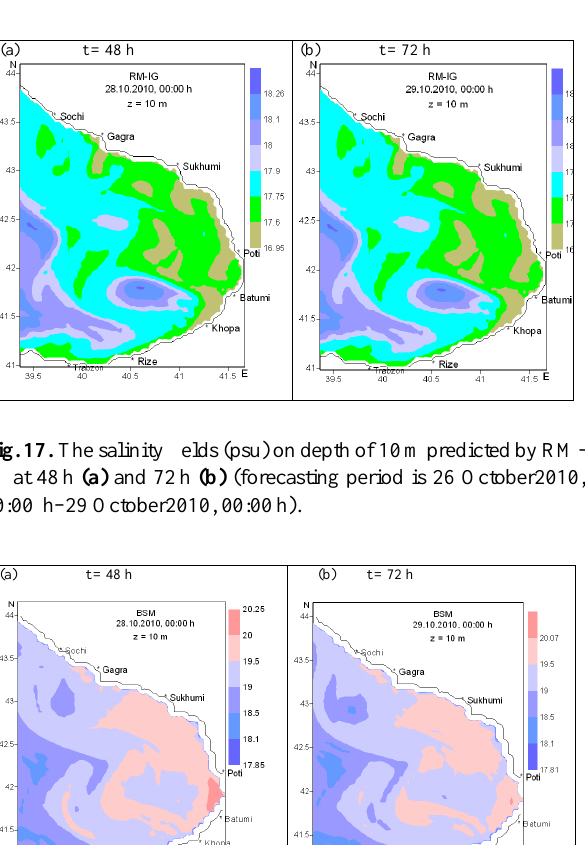
Fig. 17. The salinity fields (psu) on depth of 10 m predicted by RM-IG at 48 h (a) and 72 h (b) (forecasting period is 26.10.2010, 00:00 h – 29.10.2010, 00:00 h ). 10